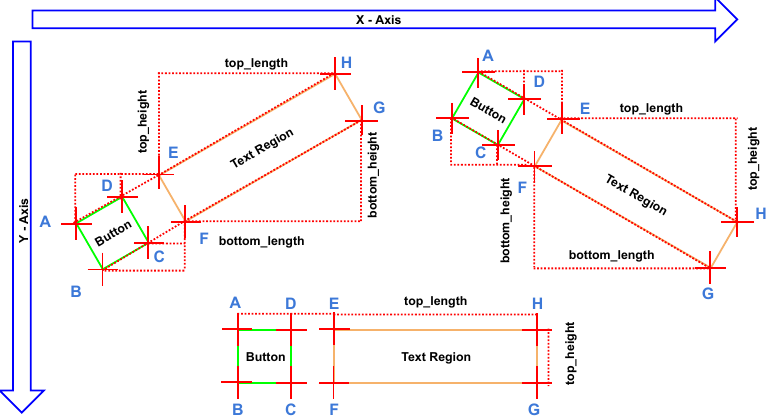
Figure 6. Illustration of determining button positions of different visual